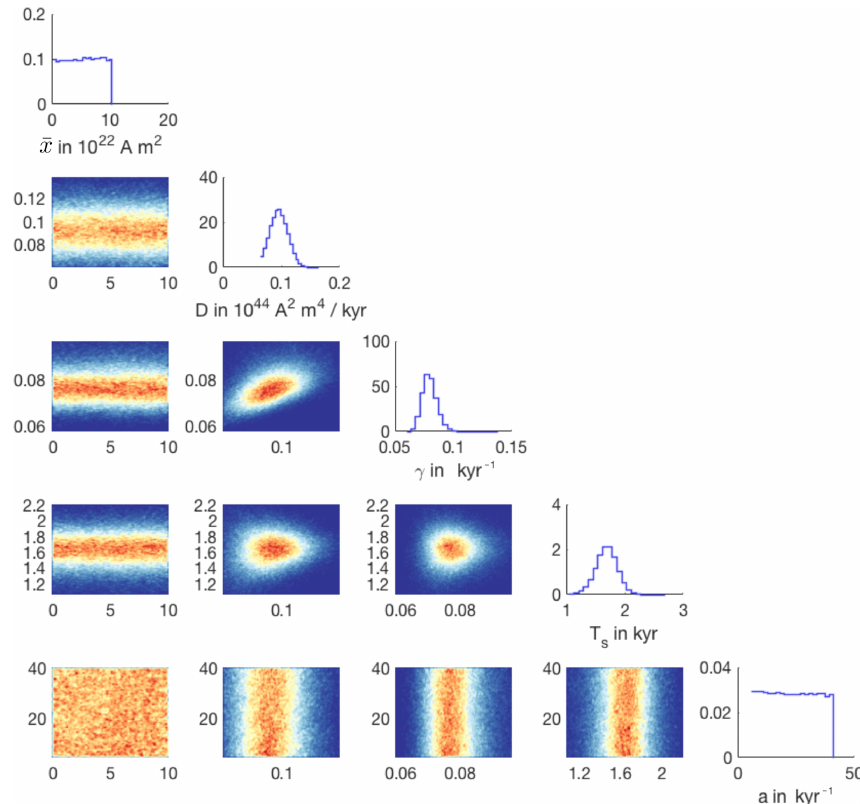
Figure 10. One- and two-dimensional histograms of the posterior distribution of configuration